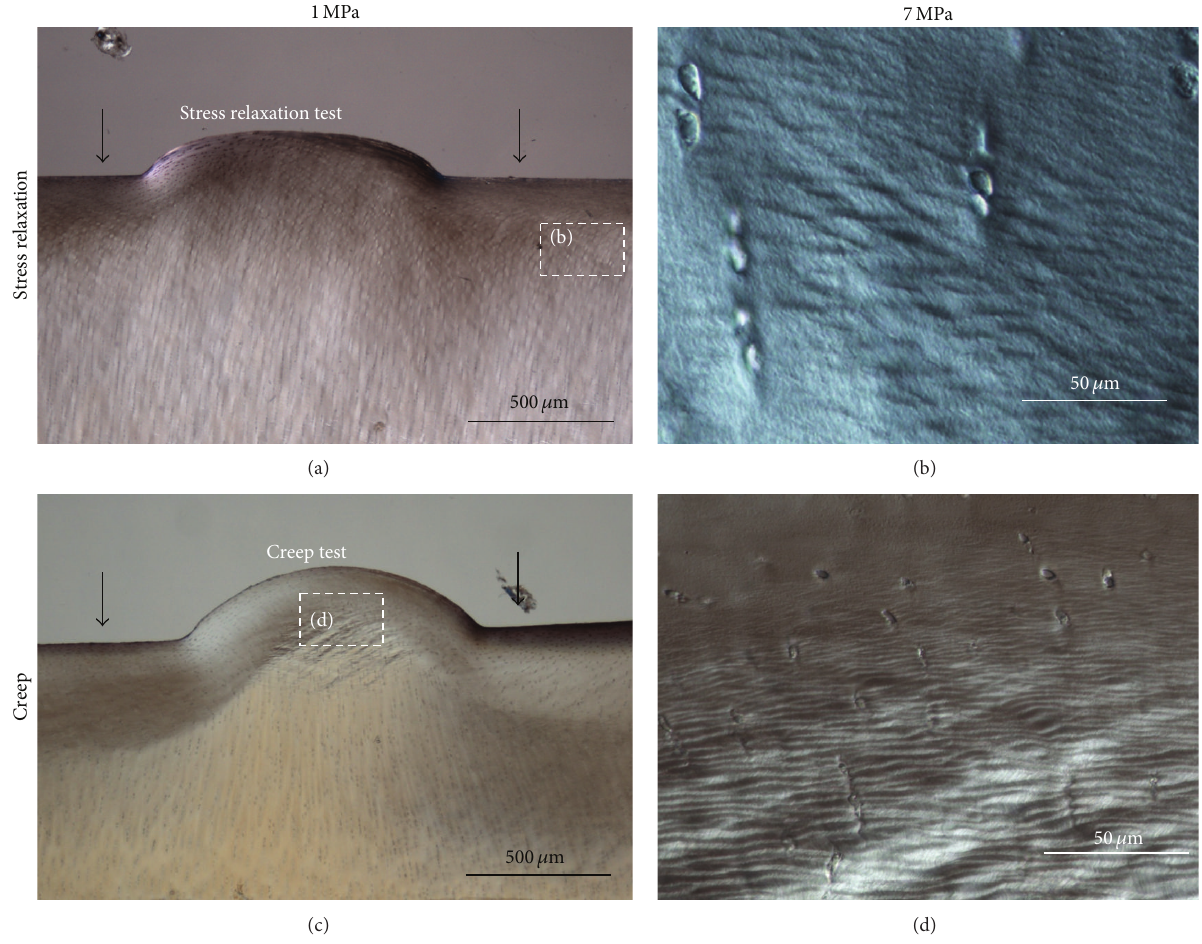
Figure 5: Comparison of the location of shear bands (boxed regions) in samples from (a) SR7 and (c) Cr1. Higher magnification views of the boxed regions are shown in (b) and (d), respectively. DIC